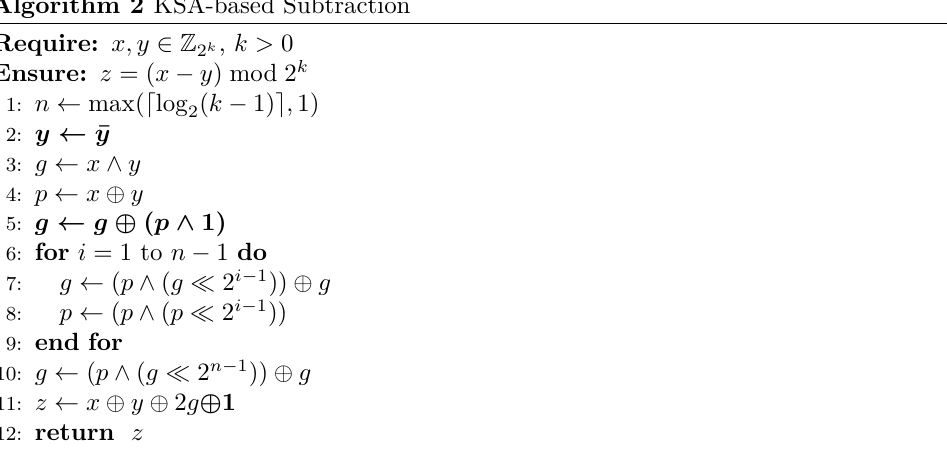
Algorithm 2 KSA-based